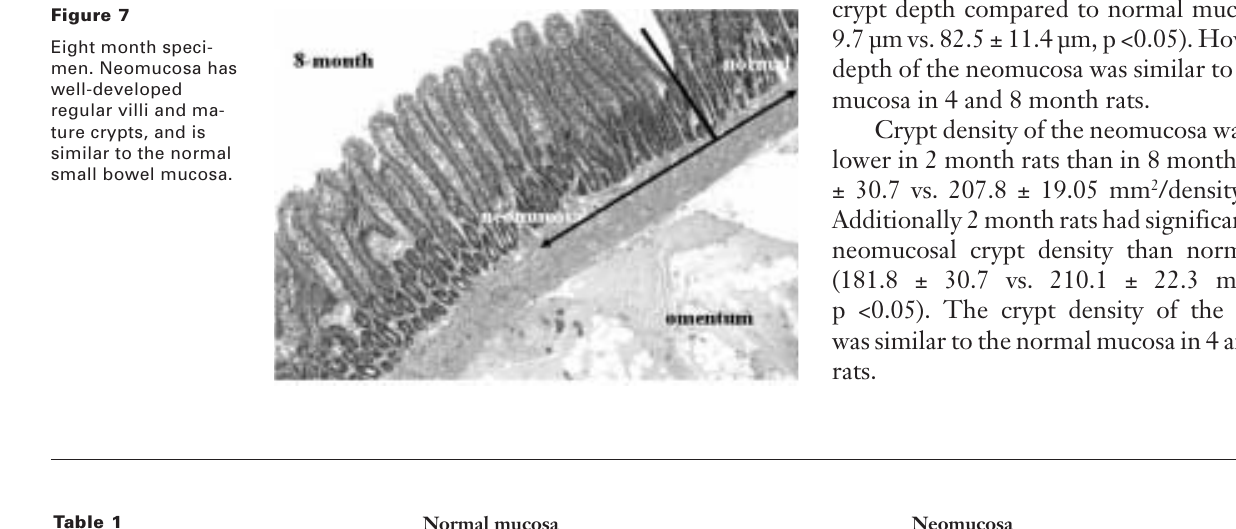
Comparison of the histopathological